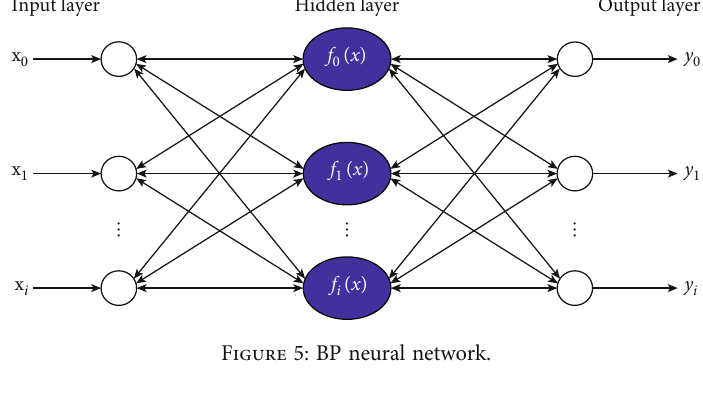
Figure 5: BP neural network.